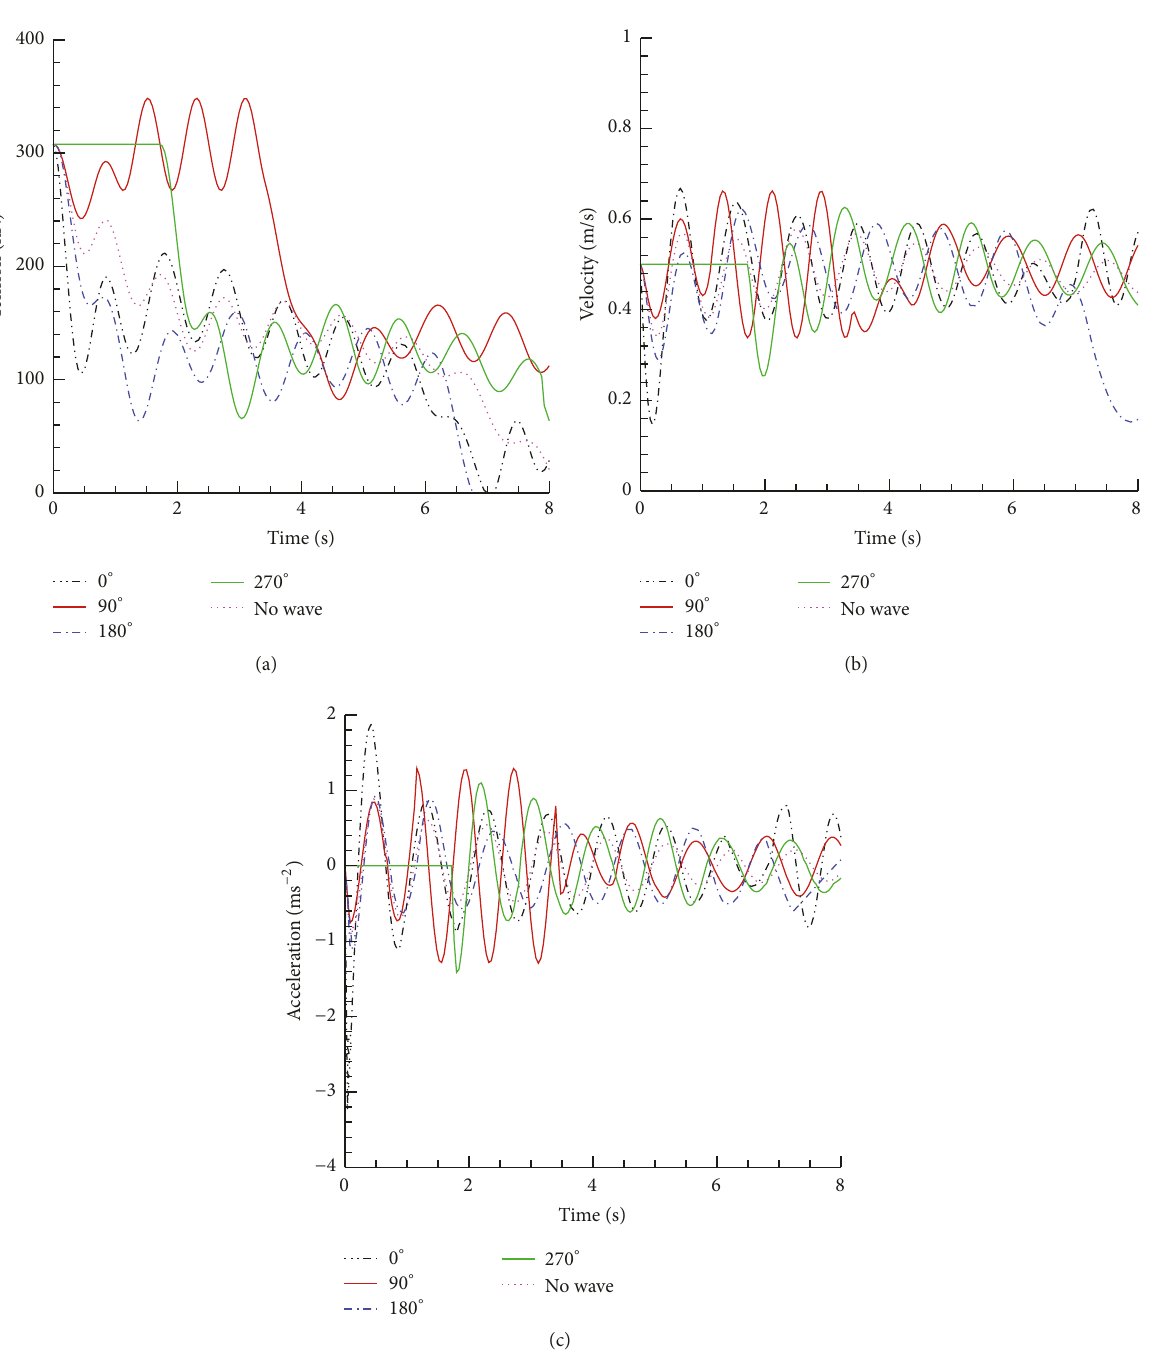
Figure 8: Influence of wave impact phase angles ( 𝑉 𝑑 = 0.5m/s): (a) tension acting on the cylinder; (b) velocity of the cylinder; (c) acceleration of the